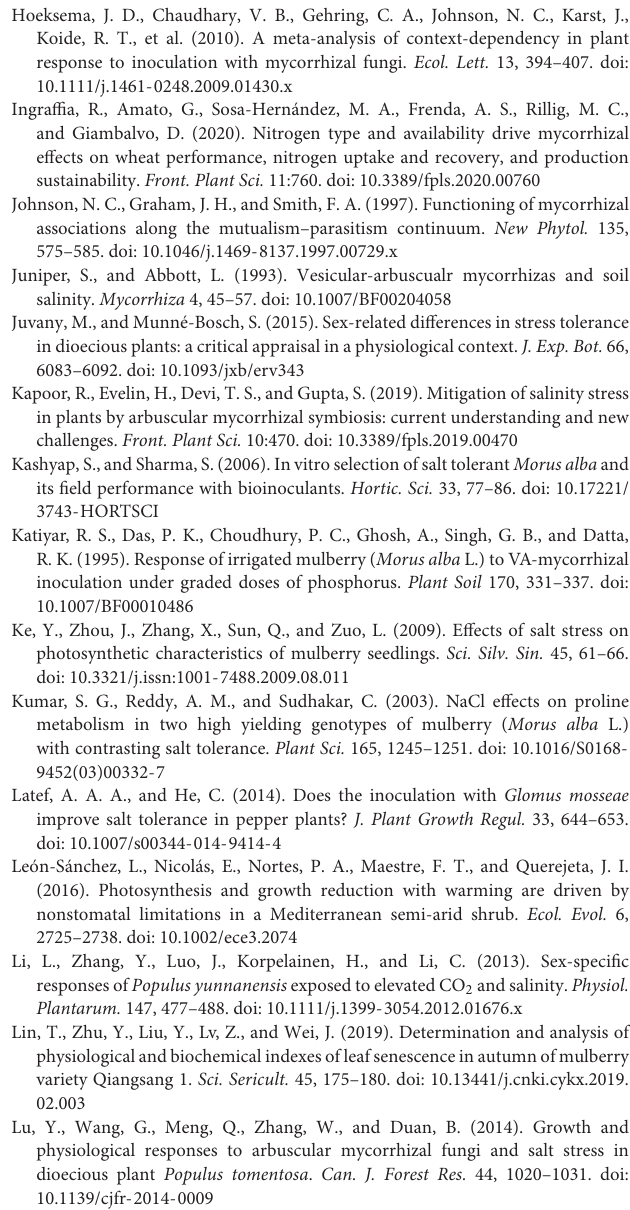
NaCl and with mycorrhizal inoculation; FCN, female plants under 0 mM NaCl and without mycorrhizal inoculation; FLN, female plants under 50 mM NaCl and without mycorrhizal inoculation; FHN, female plants under 200 mM NaCl and without mycorrhizal inoculation; FCA, female plants under 0 mM NaCl and with mycorrhizal inoculation; FLA, female plants under 50 mM NaCl and with mycorrhizal inoculation; FHA, female plants under 200 mM NaCl and with mycorrhizal inoculation. Supplementary Table 1 | F values of three-way ANOVA for the effects of sex, salt stress, and arbuscular mycorrhizal fungus and their interactive effects on the parameters of Morus alba . Supplementary Table 2 | F values of three-way ANOVA for the effects of sex, salt stress, and arbuscular mycorrhizal fungus and their interactive effects on the nutrient uptake of Morus alba